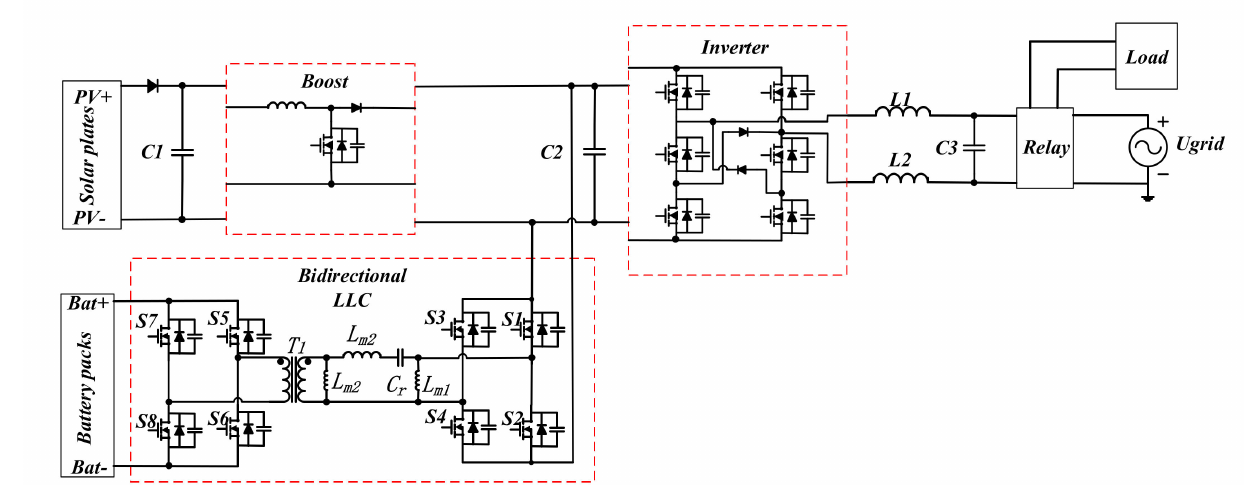
Figure 1. Structure of photovoltaic energy storage complementary